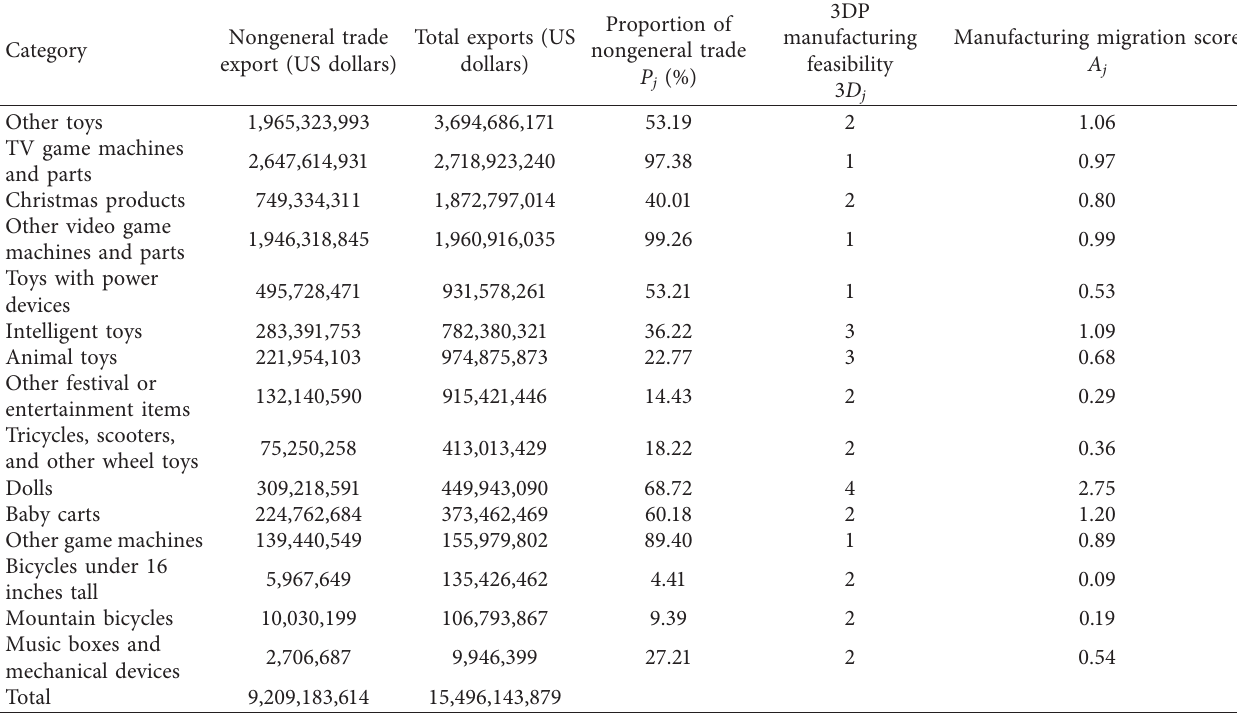
Table 5: Sorting and grading of the manufacturing activity migration score based on toy exports in 2019 (data source: authors). Category